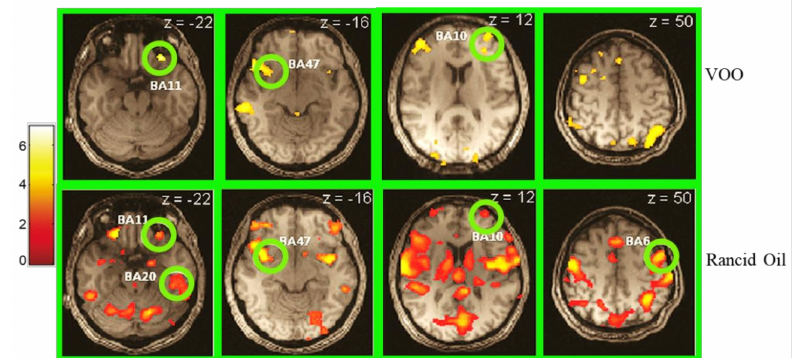
Figure 2. Results of functional Magnetic Resonance Imagining (fMRI) on the human brains of subjects exposed to rancid olive oil and extra virgin olive oil. Brodmann areas (BA) are marked with circles (Reproduced with permission from Garc í a-Gonz á lez, D.L.; Vivancos, J.; Aparicio, R., J. Agric. Food Chem.; published by ACS Publications,